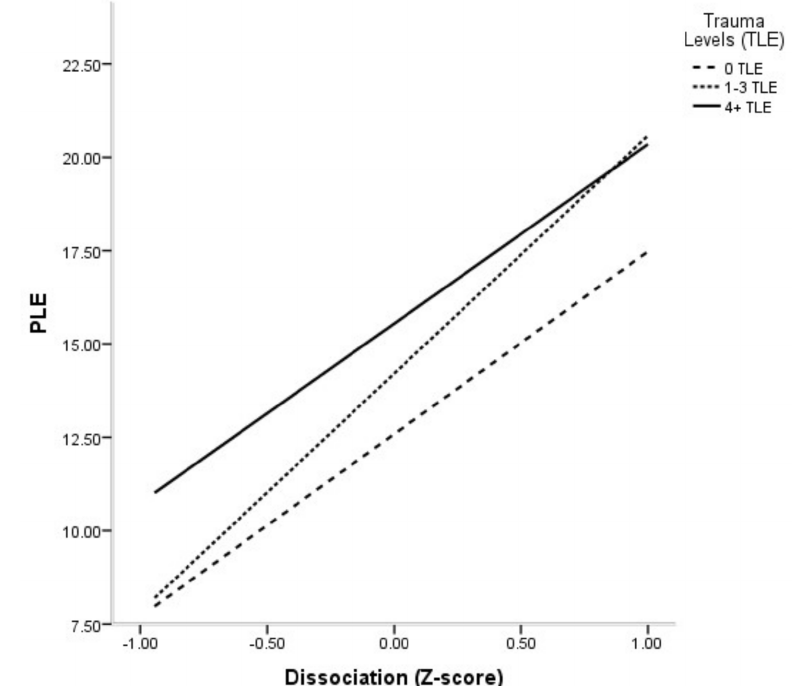
Figure 3. Interaction between dissociation and cumulative trauma levels in predicting